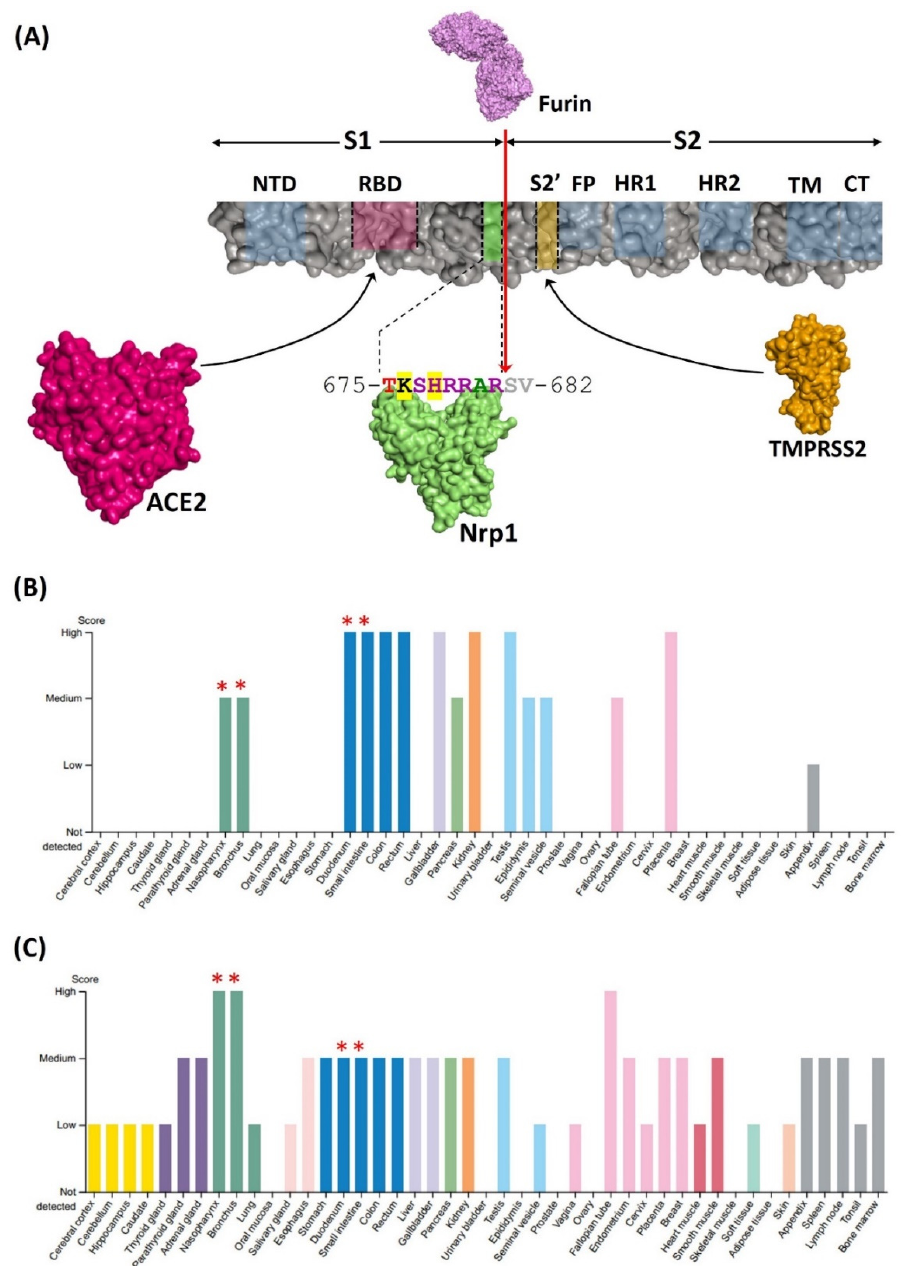
Figure 1. NRP1 as a coreceptor for SARS-CoV-2 infection. ( A ) ACE2, Nrp1, and TMPRSS2 proteins and color code-matched binding sites on spike protein domains are illustrated. The amino acid sequence of the CendR motif of the S1 domain of spike protein is shown for Omicron, where sequences altered relative to the original Wuhan variant are highlighted in yellow. The red arrowhead indicates the furin protease cleavage site that generates S1 and S2. NTD: N-terminal domain; RBD: Receptor Binding Domain; HR1 and HR2: Heptad repeats; TM: Transmembrane domain; CT: Cytoplasmic domain. ( B , C ) Data from Human Protein Atlas display tissue expression of ( B ) ACE2 and ( C ) Nrp1. Red asterisks (*) represent major infection sites of SARS-CoV-2, where both ACE2 and Nrp1 are co-expressed.